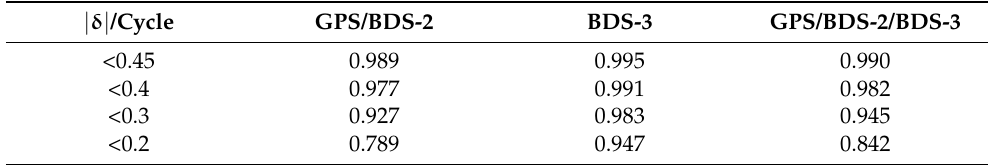
Table 6. The probability distribution of WL ambiguity fractions of GPS/BDS-2, BDS-3, and GPS/BDS- 2/BDS-3 under different thresholds | δ | .